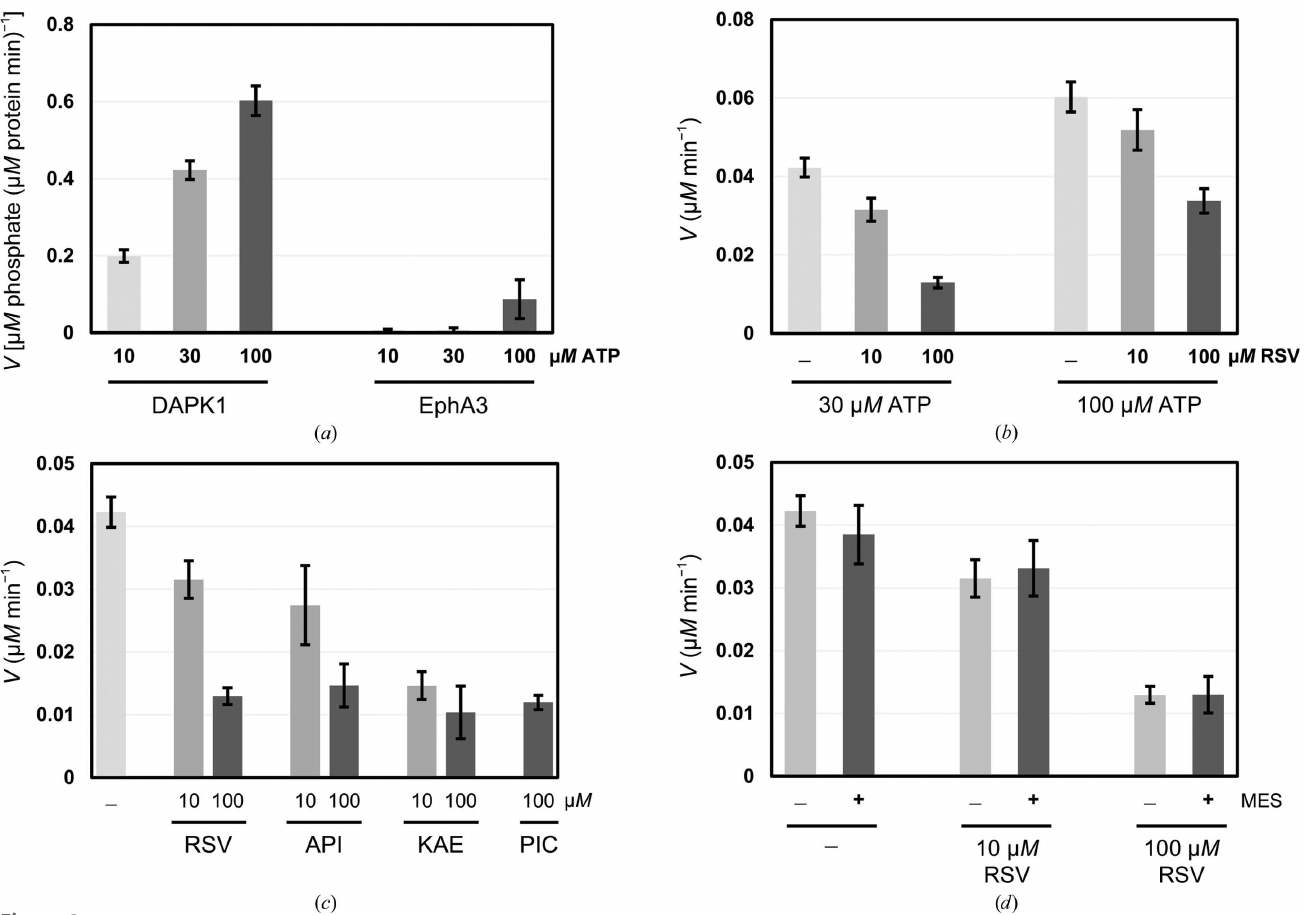
Figure 2 ( a ) DAPK1 exhibited intrinsic ATPase activity. The histogram shows the reaction rates for the ATPase activities of DAPK1 and EphA3 at 10, 30 and 100 m M ATP. The reaction rates were obtained by dividing the product concentration by the protein concentration and the reaction time. ( b ) RSV inhibited the ATPase activity of DAPK1 in a dose-dependent manner at 30 and 100 m M ATP. The reaction rates were obtained by dividing the product concentration by the reaction time. ( c ) The histograms show the inhibitory effect of RSV-related compounds against the intrinsic ATPase activity of DAPK1 at 30 m M ATP. ( d ) The presence of 10 m M MES does not influence the reaction rate either in the presence or the absence of